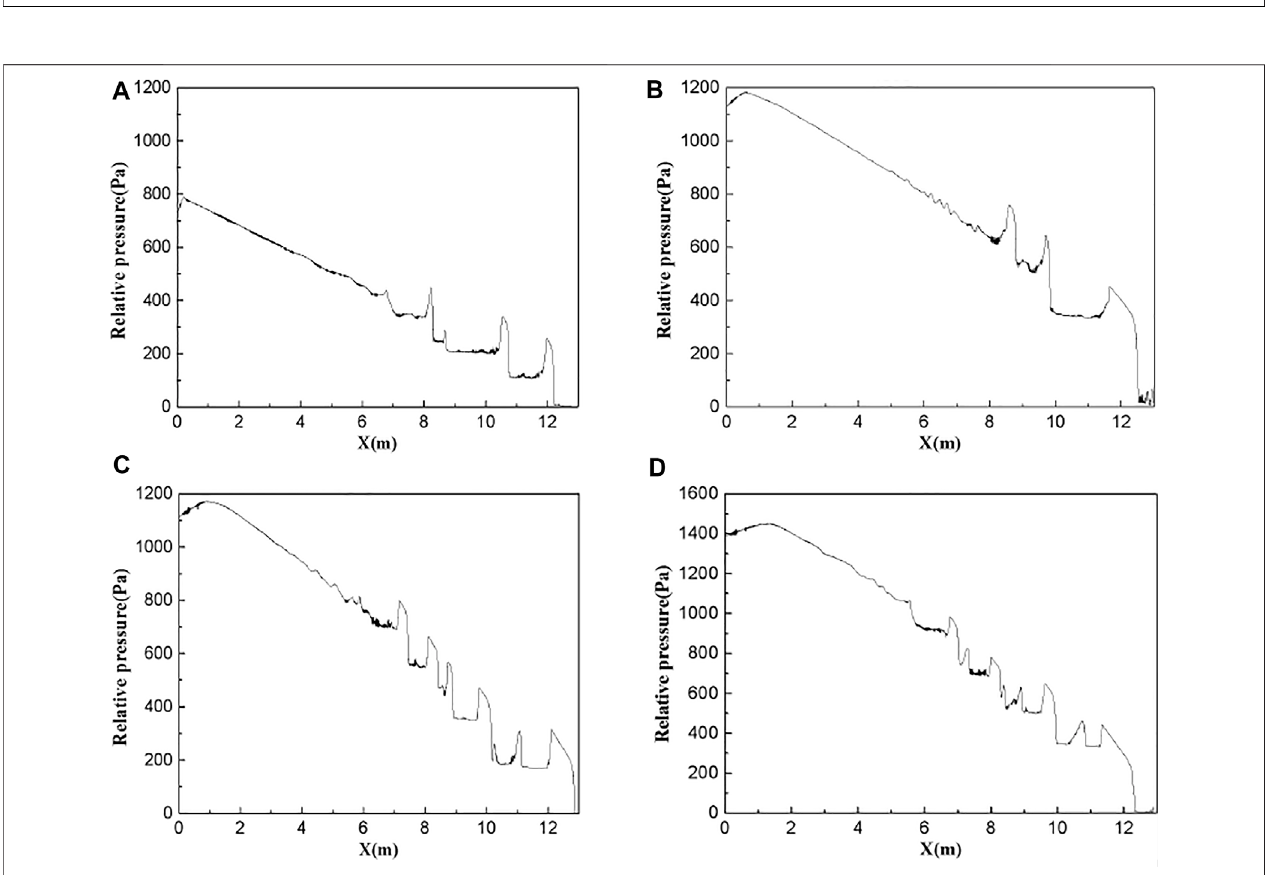
FIGURE 19 | Relative pressure distribution curves of the central axis of the pipeline at a certain moment under the following fl ow conditions: (A) V sg (cid:2) 1 m/s, V sl (cid:2) 0.6 m/s, (B) V sg (cid:2) 1 m/s, V sl (cid:2) 0.8 m/s, and (C) V sg (cid:2) 1 m/s, V sl (cid:2) 1 m/s. (D) V sg (cid:2) 1 m/s, V sl (cid:2) 1.2 m/s.